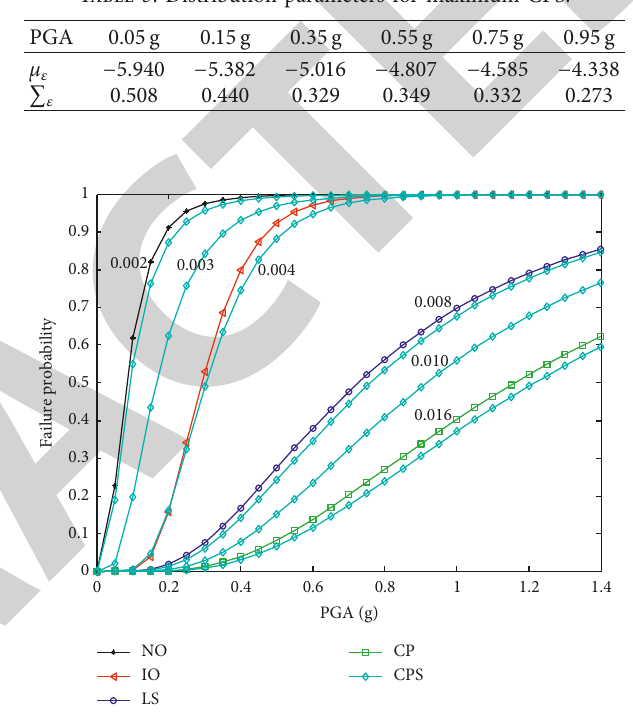
Figure 5: Comparison of two kinds of fragility curves. This figure is reproduced from [25] (under the Creative Commons Attribution License/public domain).